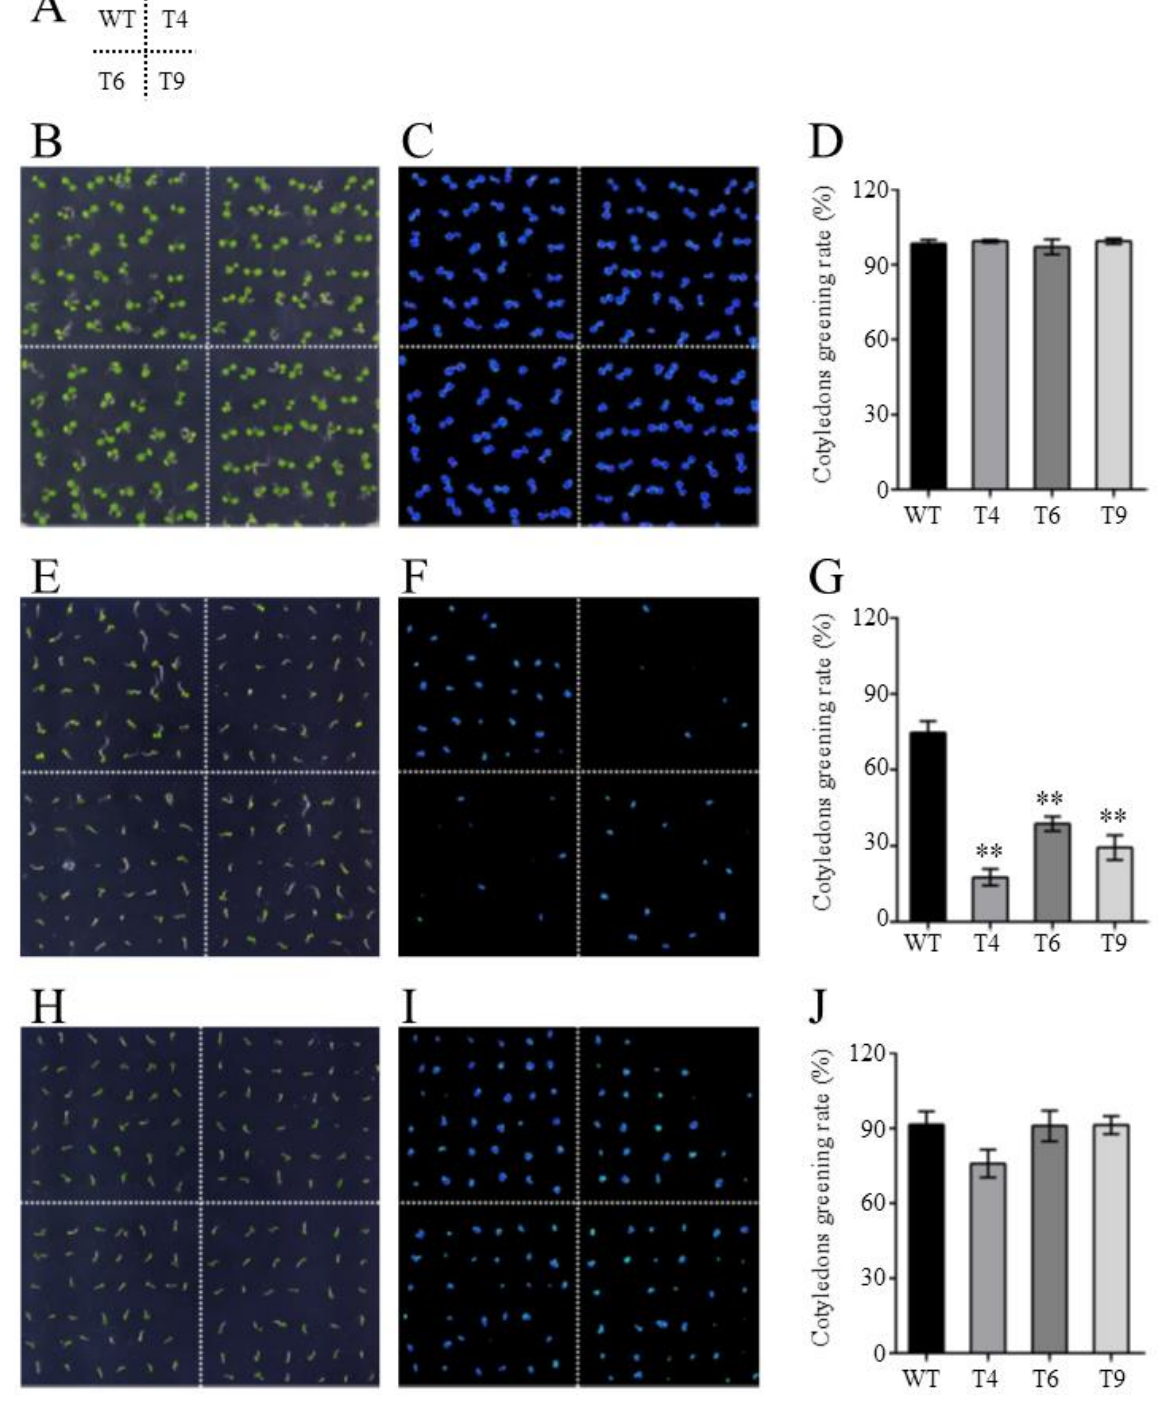
Figure 12. Effects of ABA treatment on germination rate of FtMYB22 transgenic Arabidopsis (T4, T6, and T9) lines and WT lines. ( A ) The distribution of each line on the plate. ( B – D ) Normal conditions. ( E – G ) ABA treatment. ( H – J ) ABA and ABA synthesis inhibitors treatment. WT, wild-type. Data are presented as mean and SD values of three independent experiments. Error bars indicate SD. ** means extremely significant difference at p < 0.01 level.